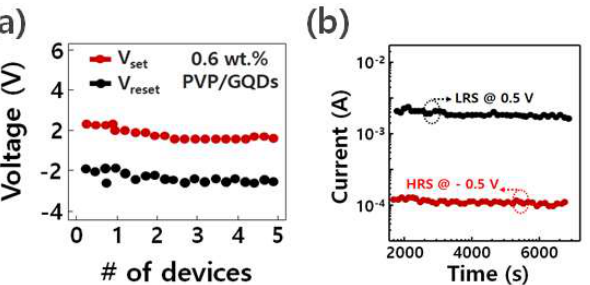
Figure 3. ( a ) Device-to-device variation of the switching; ( b ) a plot of retention time measurement by applying voltages of −0.5 V and 0.5 V in HRS and LRS, respectively. These oxygen vacancies can be considered as pervasive point defects in metal oxides.